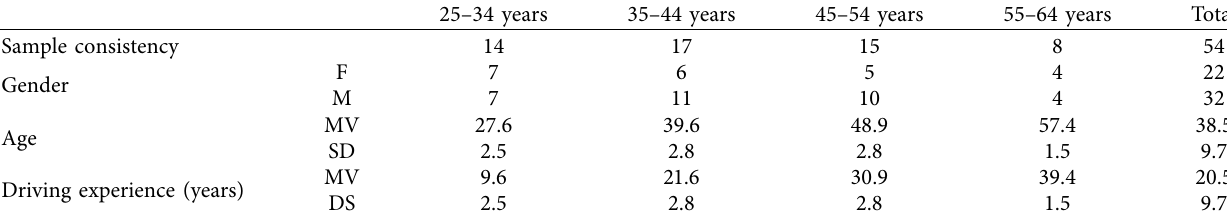
Table 2: Participant characterization according to the factors